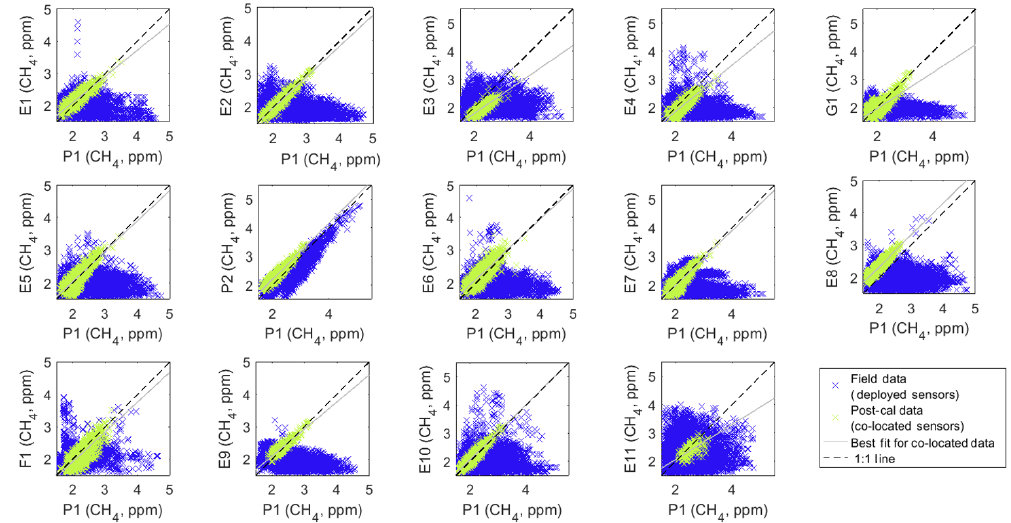
Figure A1. Scatter plots of P1 versus every other Y-Pod including both co-located data (in green) and deployed data (in blue).